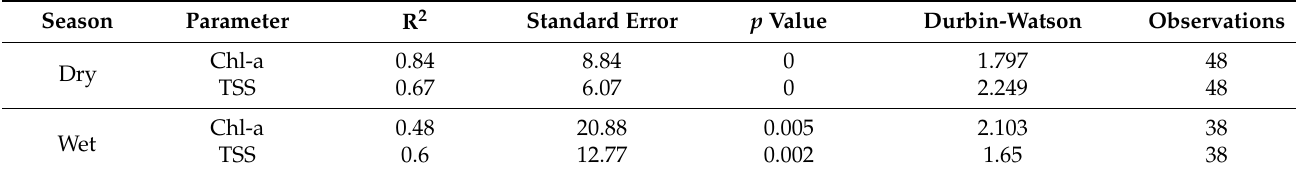
Table 3. Regression analyses for chl-a and total suspended solid (TSS).